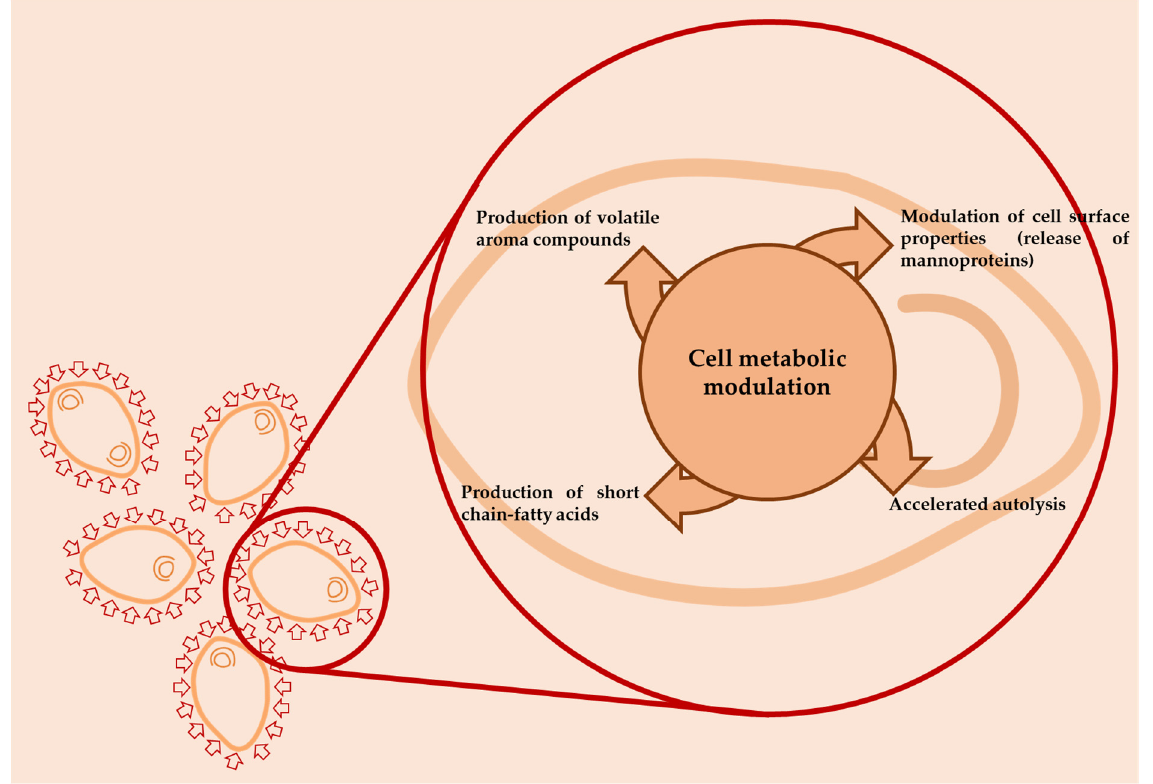
Figure 4. Sublethal HPH process applied to yeast cell to modify cell metabolism, autolysis, and production of volatile aroma compounds.